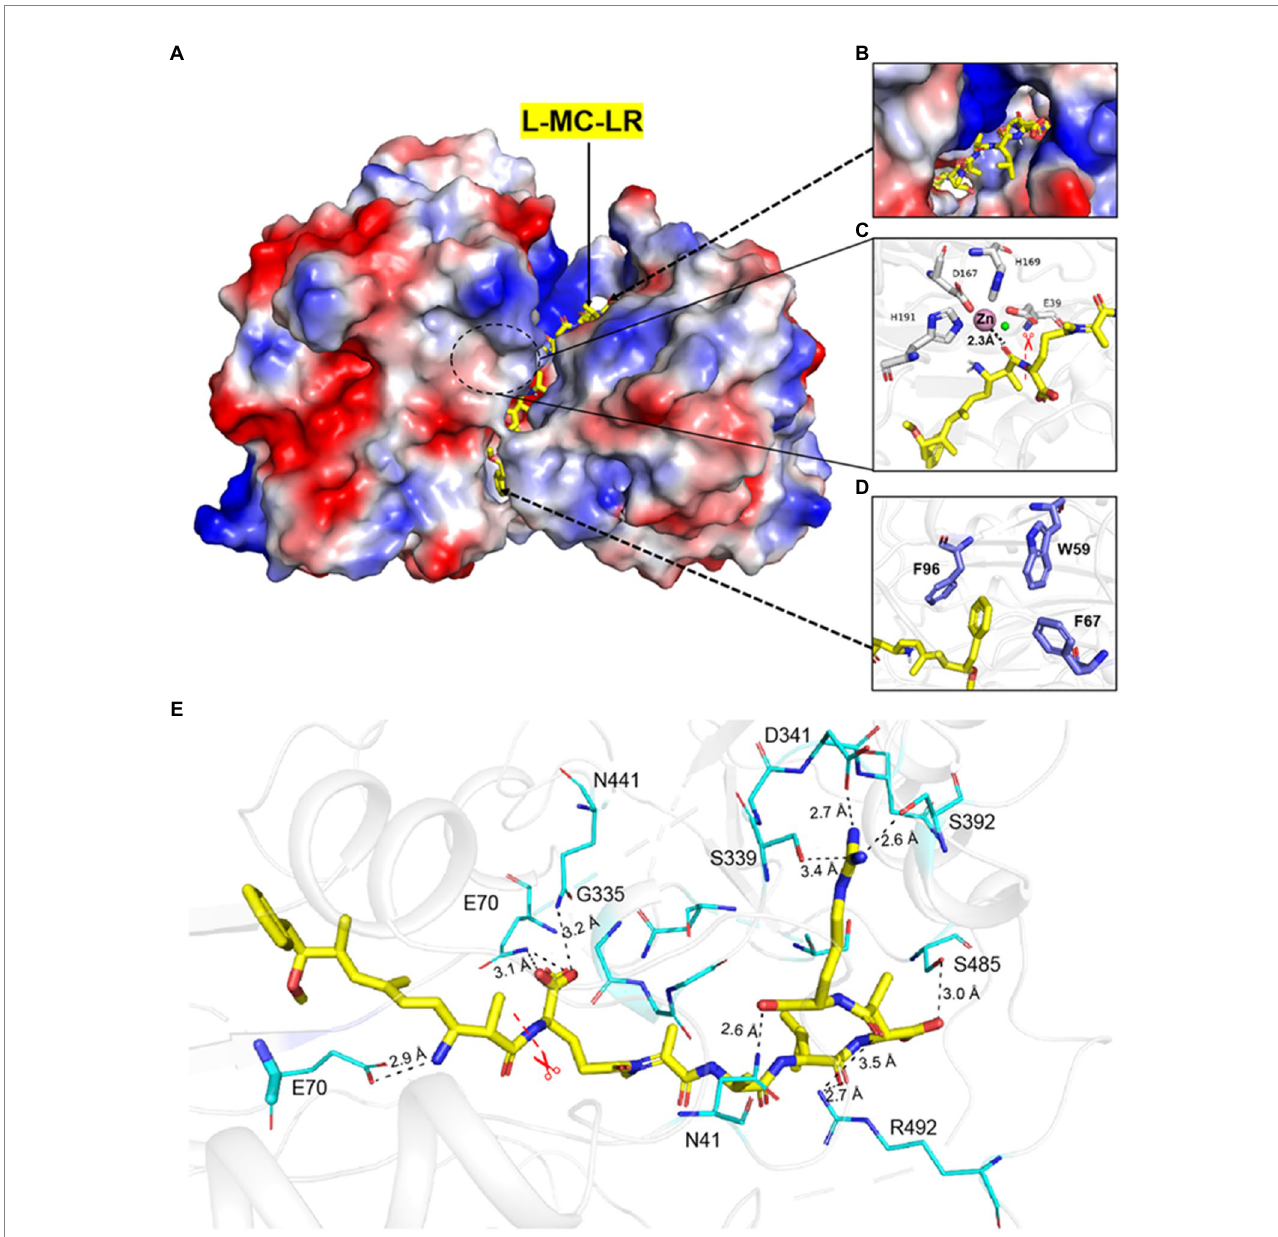
FIGURE 1 Interaction between MlrC and substrates. (A–D) The catalytic triad and the docking model of the reaction intermediate of linearized MC-LR in MlrC. (E) Residues involved in the binding site of MlrC. The MlrC structure is presented as a cartoon diagram in gray. Residues involved in binding linearized MC- LR are shown as a line model, and the amide bond that was cleaved by the enzyme is indicated with a star mark. The linearized MC-LR docking model is shown as a yellow stick figure. The hydrogen bonds formed between the residues and the substrate are shown as black